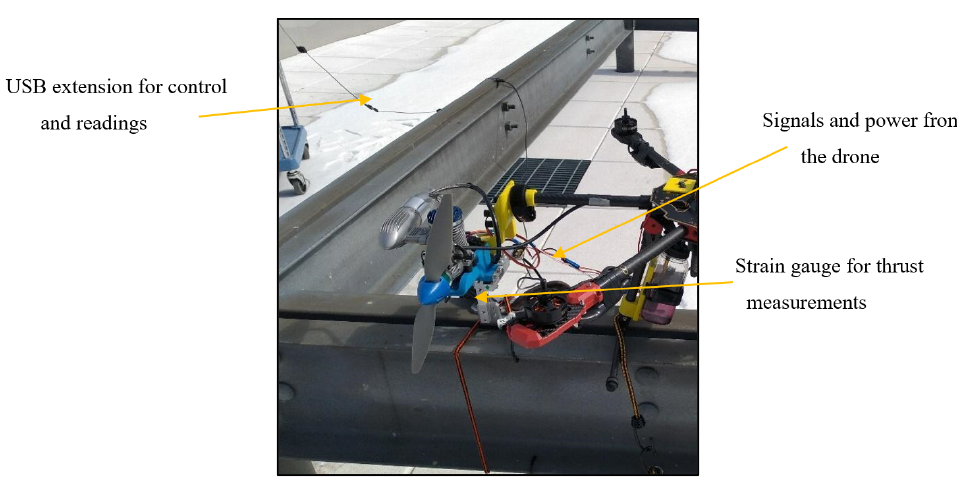
Figure 10. Gasoline engine test setup (thrust vs.